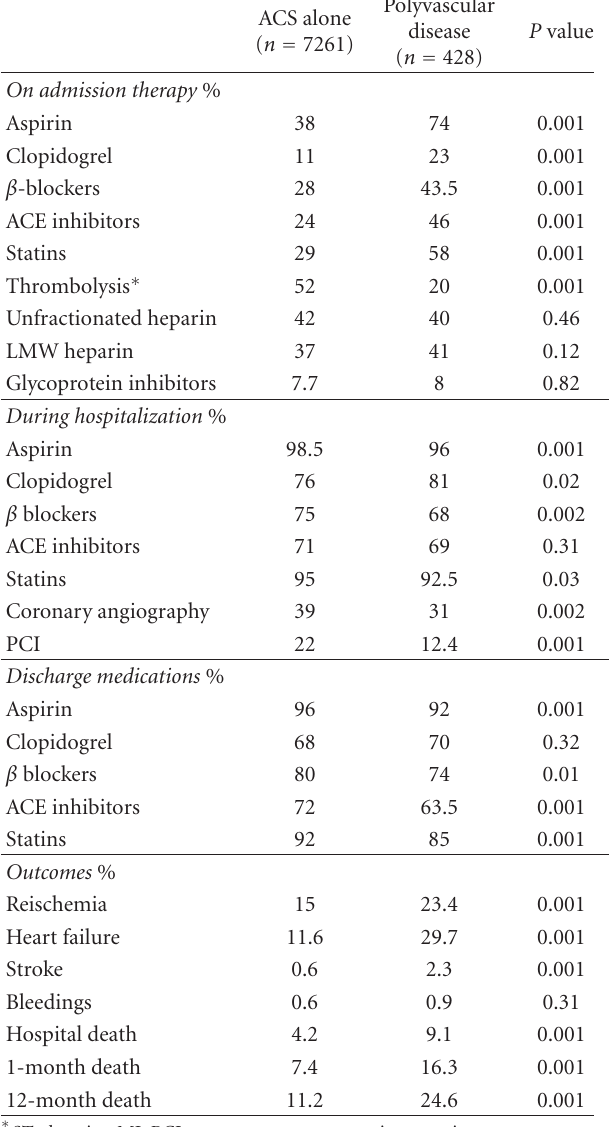
Table 1: Risk factors and clinical and laboratory findings in patients with acute coronary syndrome with and without polyvascular dis- ease.